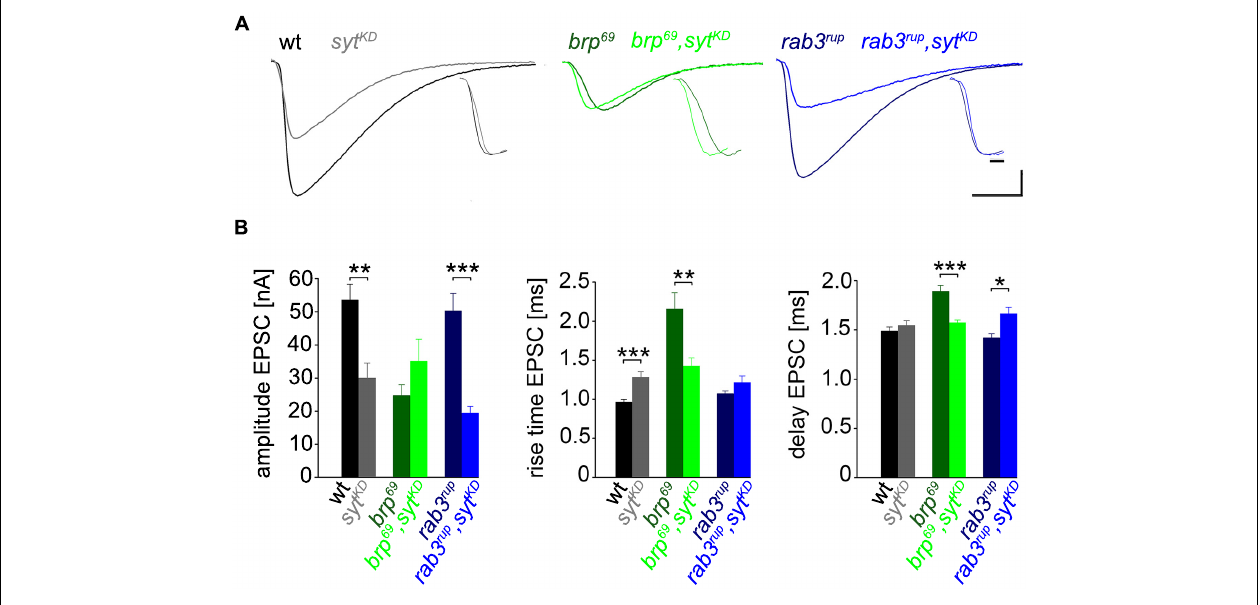
syt KD (brighter shades). Insets show normalized events to highlight the differences in synaptic delay and postsynaptic current rise time. Scale bars = 5 ms, 10 nA (main traces), and 1 ms (insets). (B) Summary bar graphs for mean ± SEM amplitude, current rise time and synaptic delay for all six genotypes, color coded as in (A)